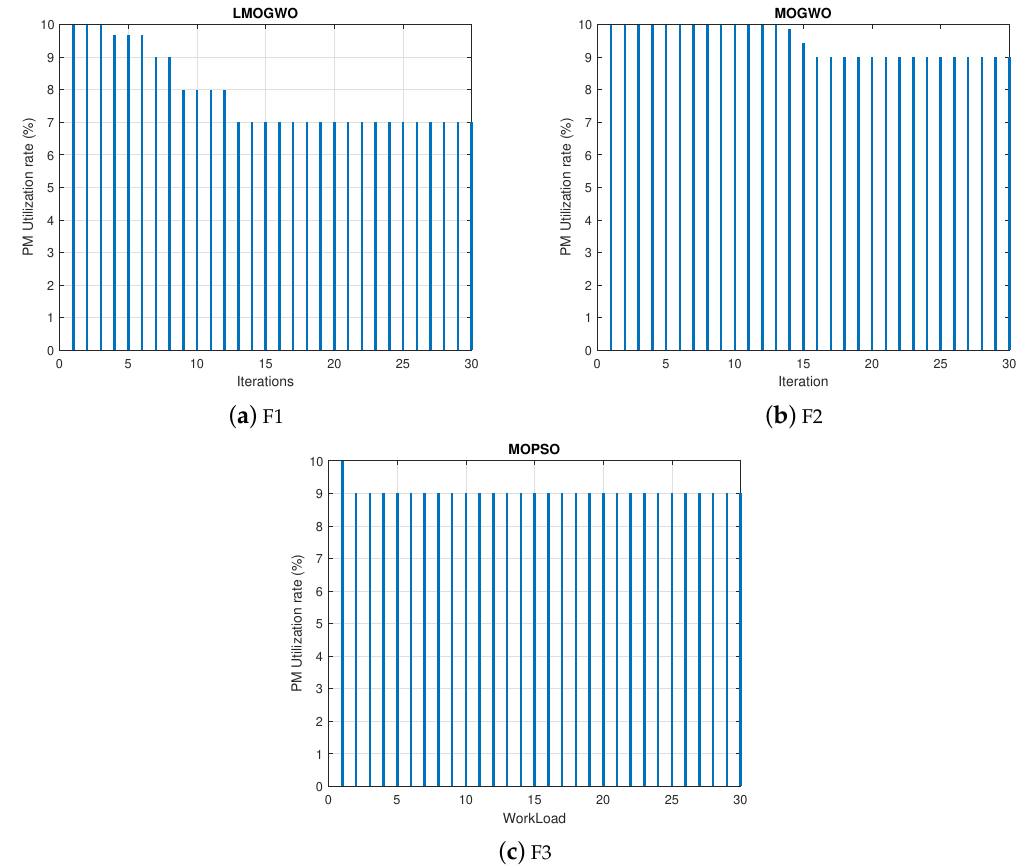
Figure 12. Results of LMOGWO, MOGWO and MOPSO using bin